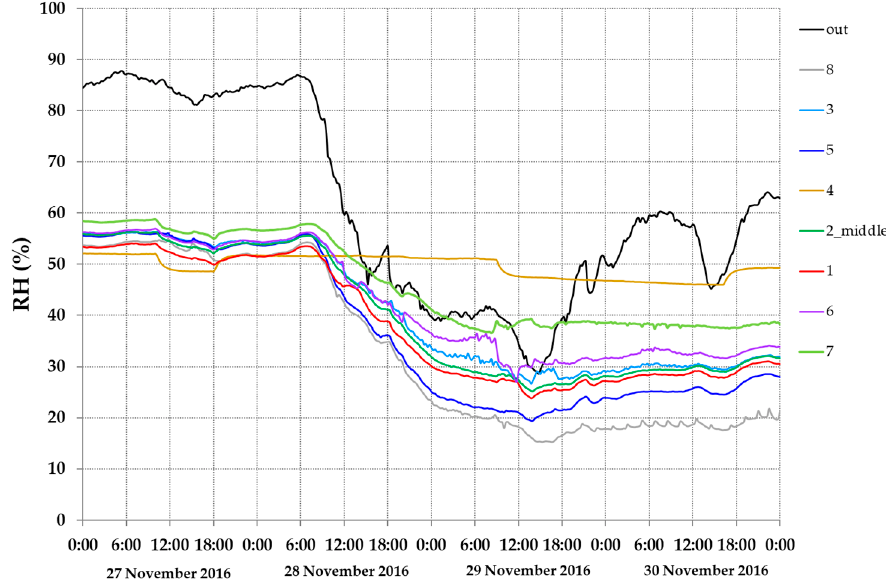
Figure 11. RH trend at the end of November 2016 outside, inside the Hall of Palms and inside the showcases (2_high point was very similar to 2_middle and is not reported).